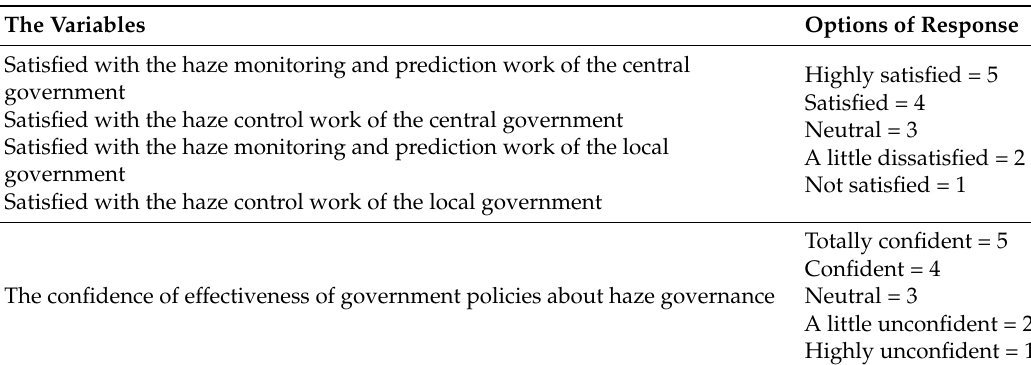
Table 3. Confidence and satisfaction in government